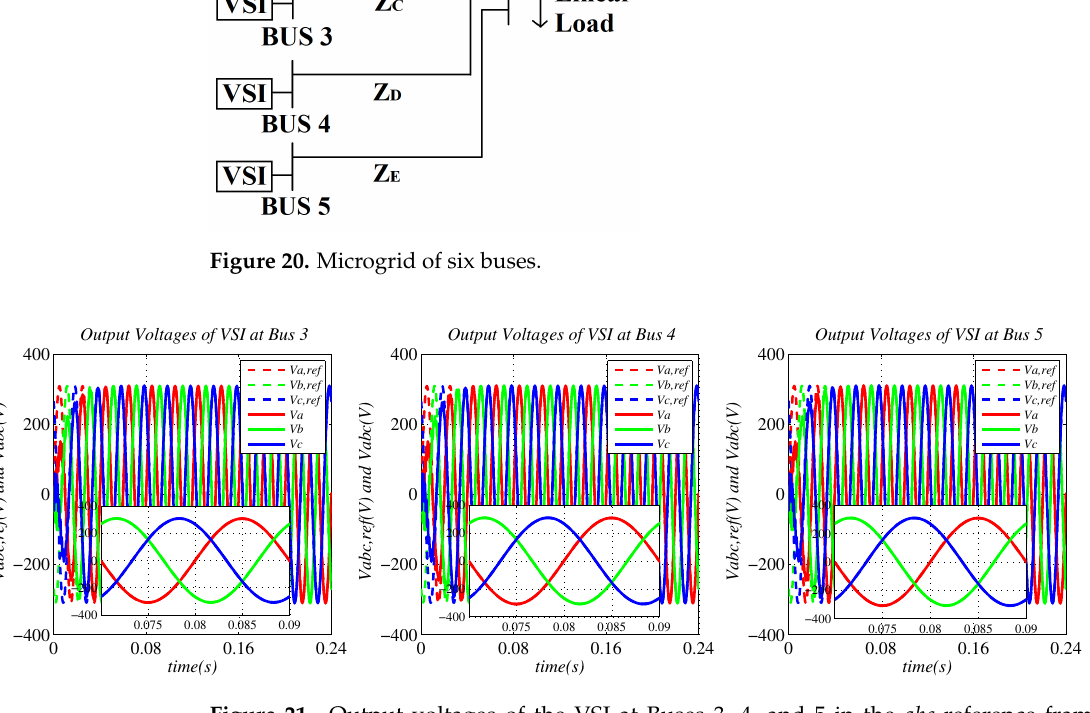
Figure 21. Output voltages of the VSI at Buses 3, 4, and 5 in the abc reference frame (six-bus